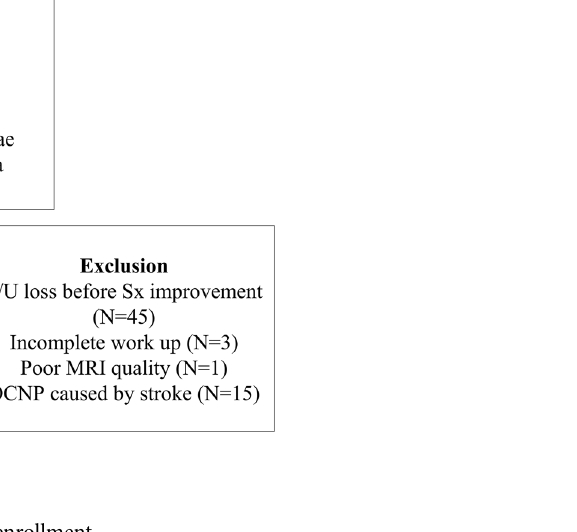
Figure 1. Flow chart of patient